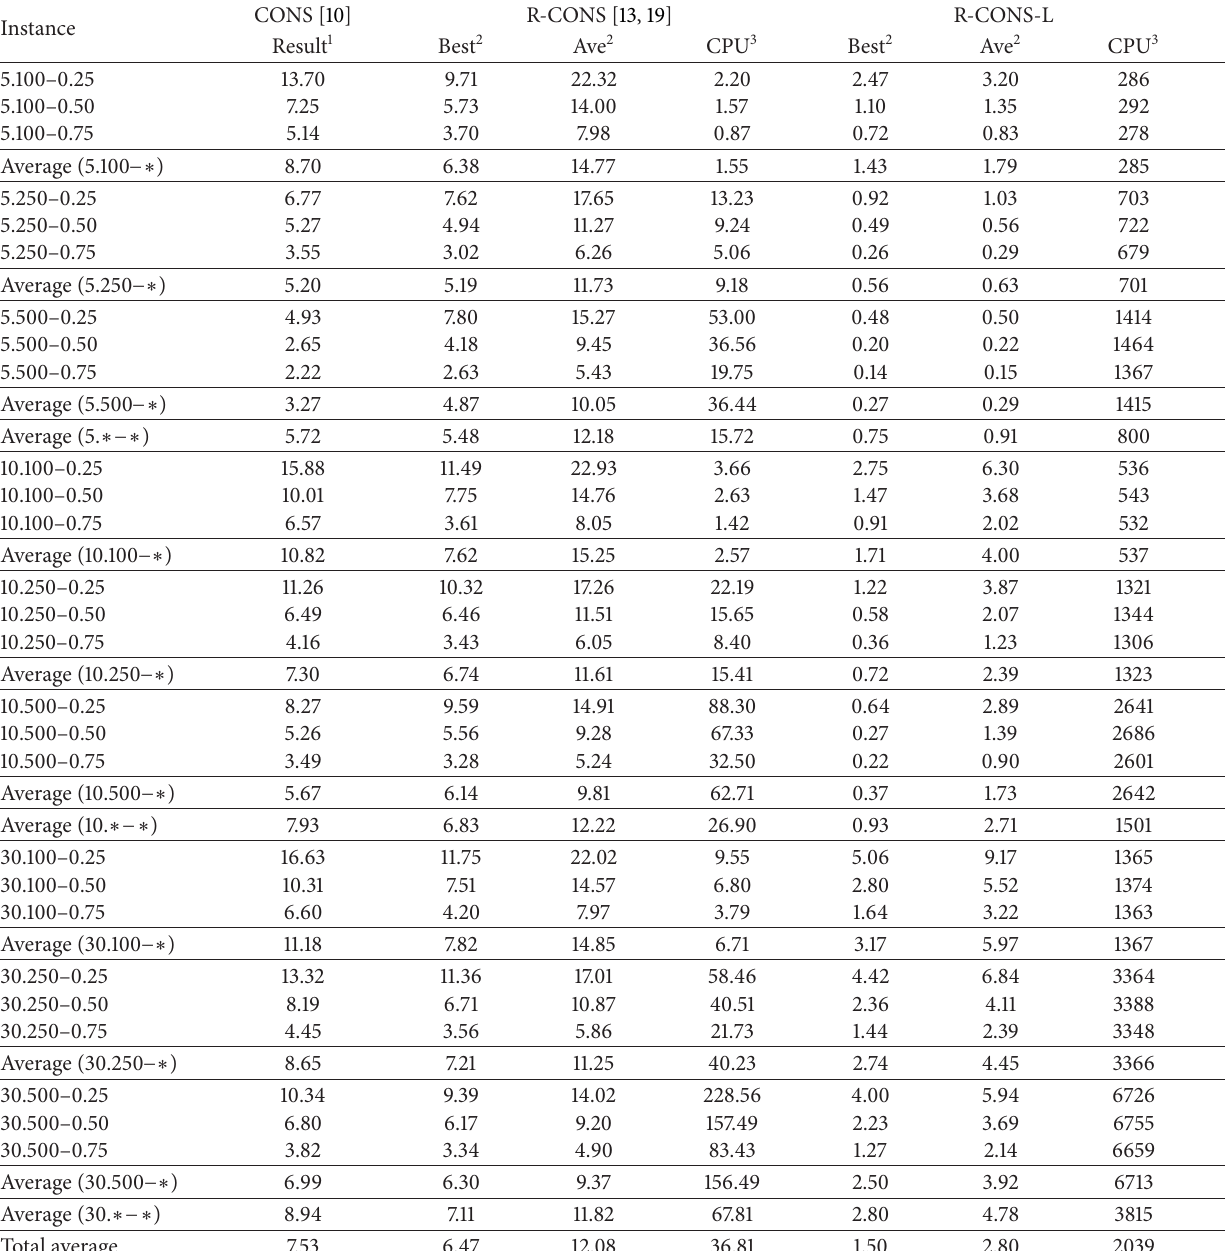
Table 1: Results of local search heuristics on benchmark